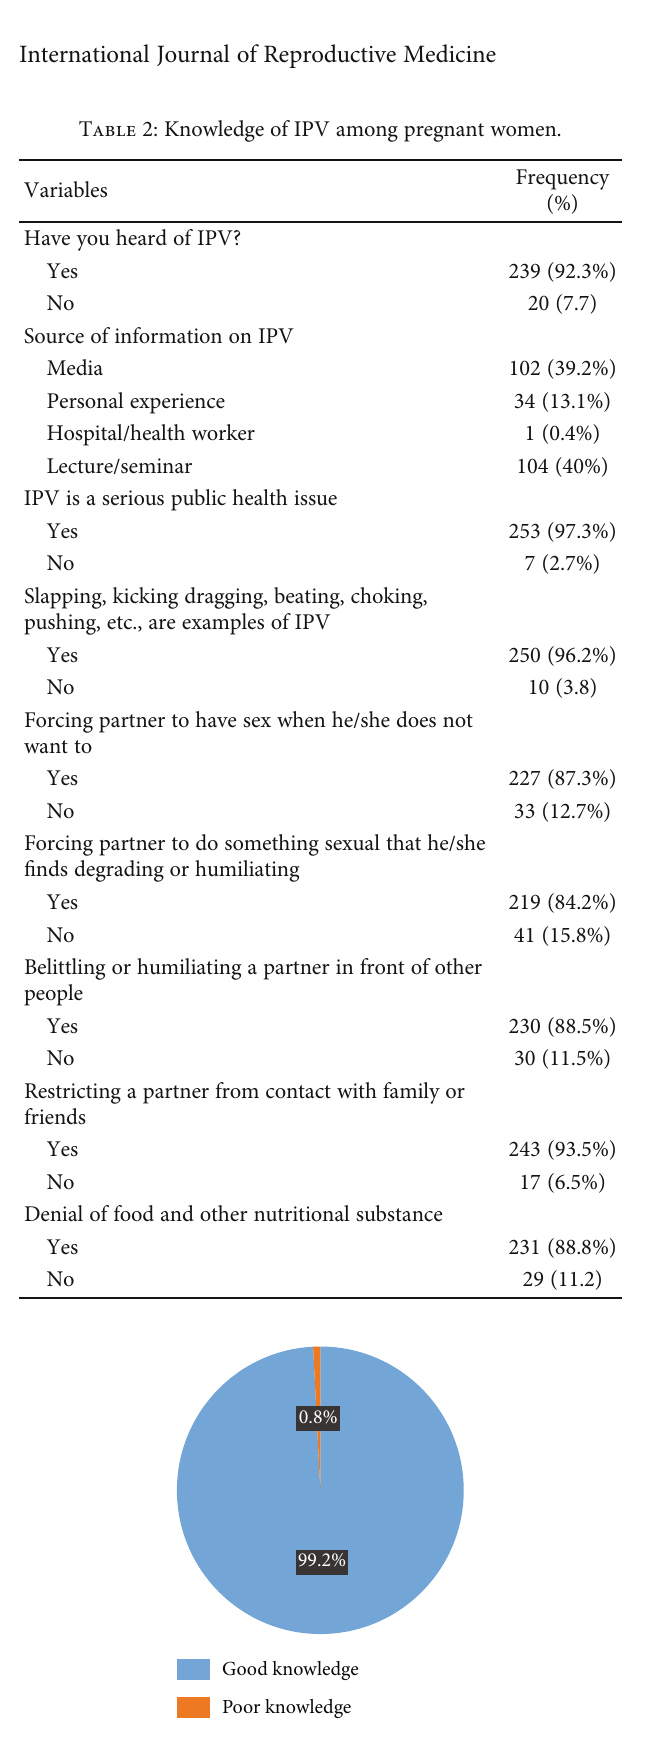
Figure 1: Knowledge of intimate partner violence.